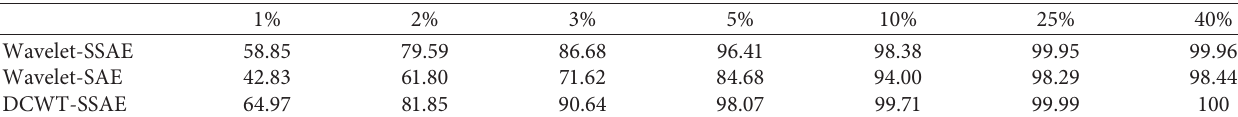
Table 1: Performance comparison of the developed DCWT-SSAE method and wavelet-SSAE trained by different percentages of samples (unit: %).